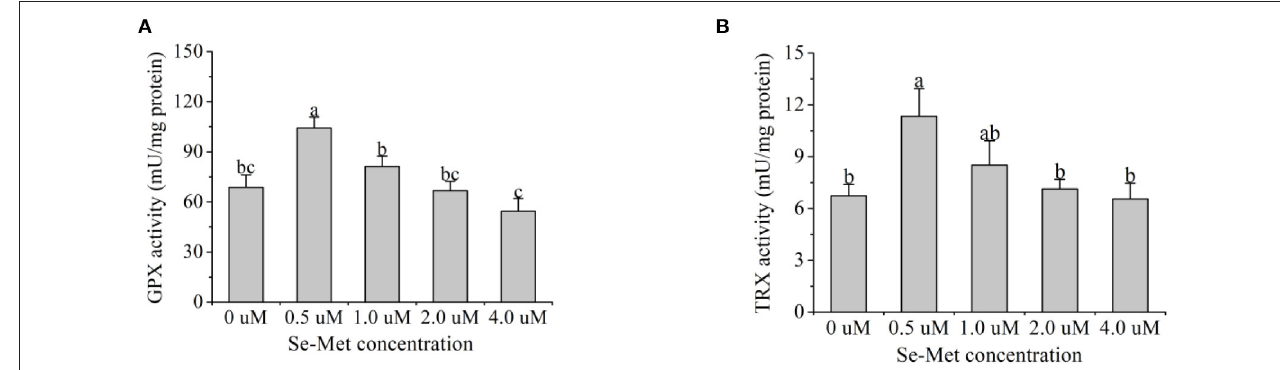
FIGURE 8 | Effects of selenomethionine (Se-Met) supplementation on glutathione peroxidase (GPX) (A) and thioredoxin reductase (TRX) activity (B) in porcine mammary epithelial cells (pMECs). The cells were incubated for 48h with different concentrations of Se-Met (0, 0.5, 1, 2, and 4 µ M), and then collected for GPX and TRX activity analysis. The data are expressed as the mean ± SEM ( n = 6). Different superscript letters indicate a significant difference ( p <